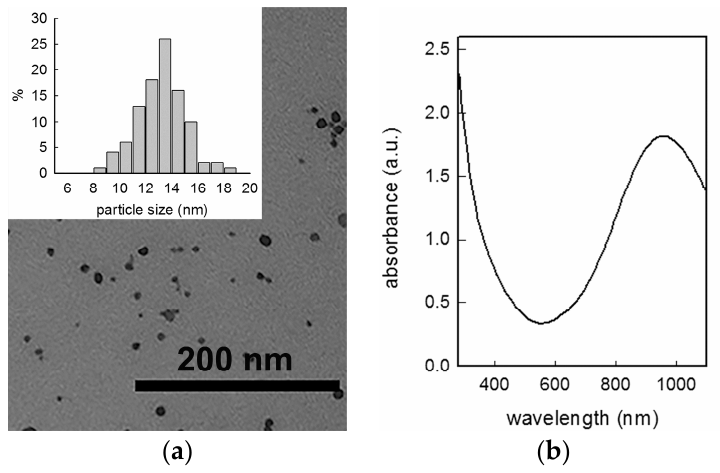
Figure 1. ( a ) Representative TEM image with histogram of size distribution (inset) and ( b ) UV-Vis-NIR spectrum of CuS NP obtained with 7 × 10 − 4 M citrate concentration.